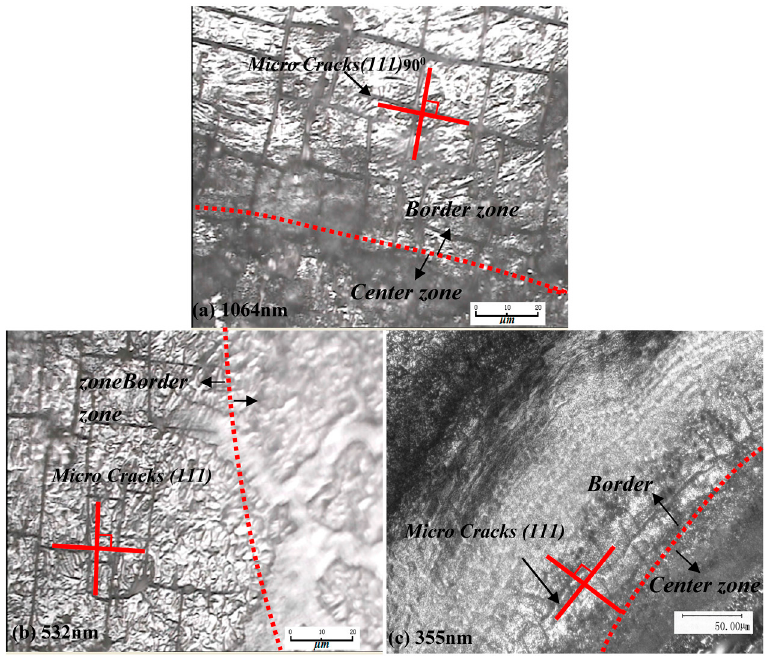
Figure 5. Cleavage failure under laser shock waves.